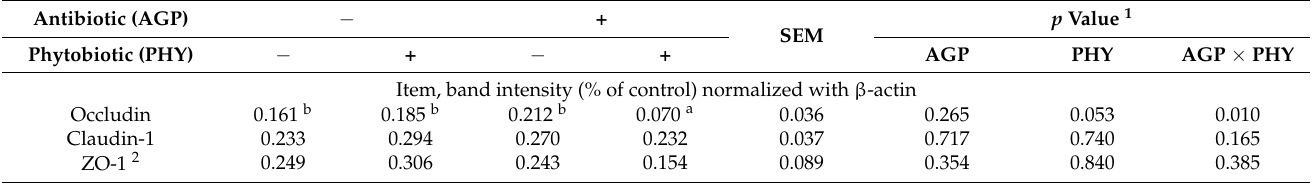
Table 7. Tight junction proteins in jejunal tissue of nursery pigs fed diets supplemented with phytobiotics and antibiotics as growth promoters (Exp. 1).